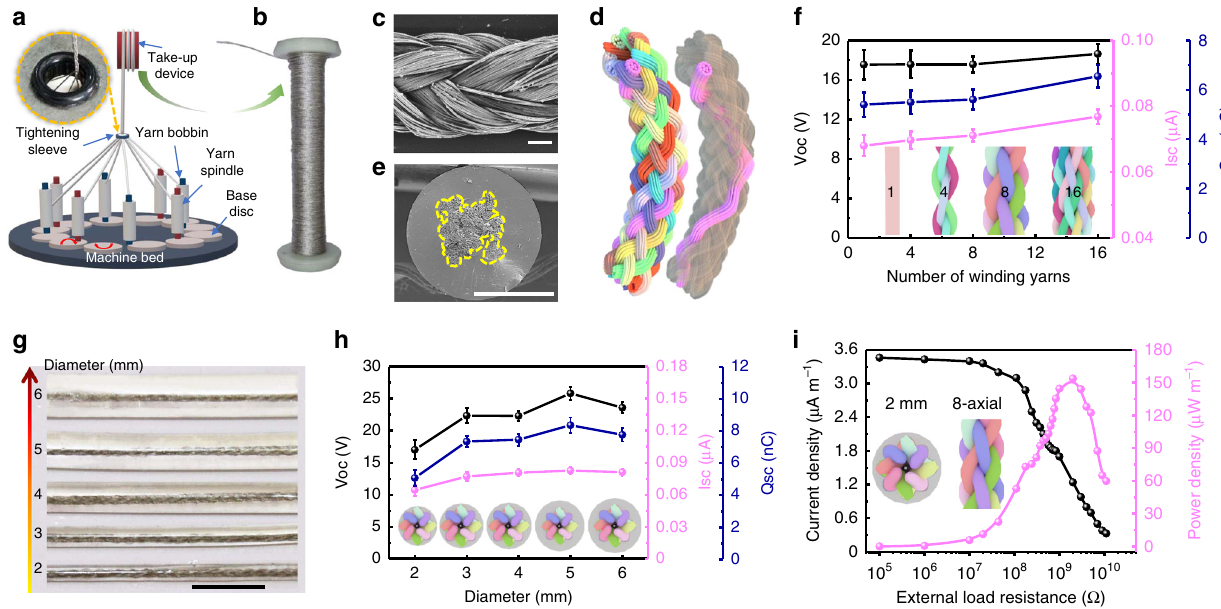
Fig. 1 Structural design and performance analysis of the PDMS-coated energy yarn. a Schematic illustration of the multiaxial yarn winding machine. The enlarged photograph in its top left is the tightening sleeve. b Photograph of a bobbin wrapped with a continuous multiaxial winding yarn. c Surface morphology SEM image of a ten-axial winding yarn (scale bar: 200 μ m). d Structural diagram of the ten-axial winding yarn. The purpose of different color design is to facilitate the observation of distribution and moving trend of a single yarn in the multiaxial winding yarn. e Cross-sectional SEM image of the PDMS-coated energy yarn (scale bar: 1 mm). f Effect of the number of winding yarns on electrical output performance of the PDMS-coated energy yarn. g Photograph of the PDMS-coated energy yarns with different diameters (scale bar: 10 mm). h Diameter-dependent electrical output performance of the PDMS-coated energy yarn. i Dependence of current density and power density of the PDMS-coated energy yarn with 2 mm diameter and 8 axial winding yarn on the external resistances under the tapping frequency of 3 Hz. The error bar indicates the range within a standard deviation. Source data are provided as a Source Data fi